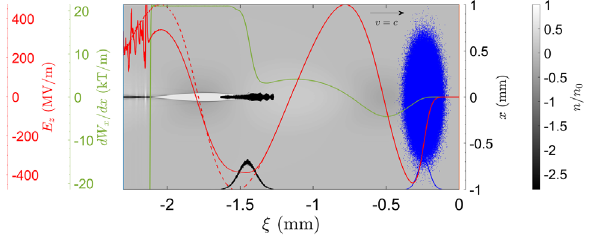
curve.FIG. 17. Plasma wakefield driven by a single proton bunch (blue dots). The electron beam (black dots) is injected to be accelerated with a strong focusing gradient. The solid red plot indicates the longitudinal plasma wakefield with a witness electron beam, while the dashed red line represents the wakefield created only by the proton beam. The transverse focusing field ¼ E − cB W and the focusing gradient (green line) were x x y evaluated near the axis ( x ∼ 0 ). The longitudinal coordinate ξ ¼ z − ct . Here, n=n 0 ( n=n 0 ) means there are more 0 > 0 < positively (negatively) charged